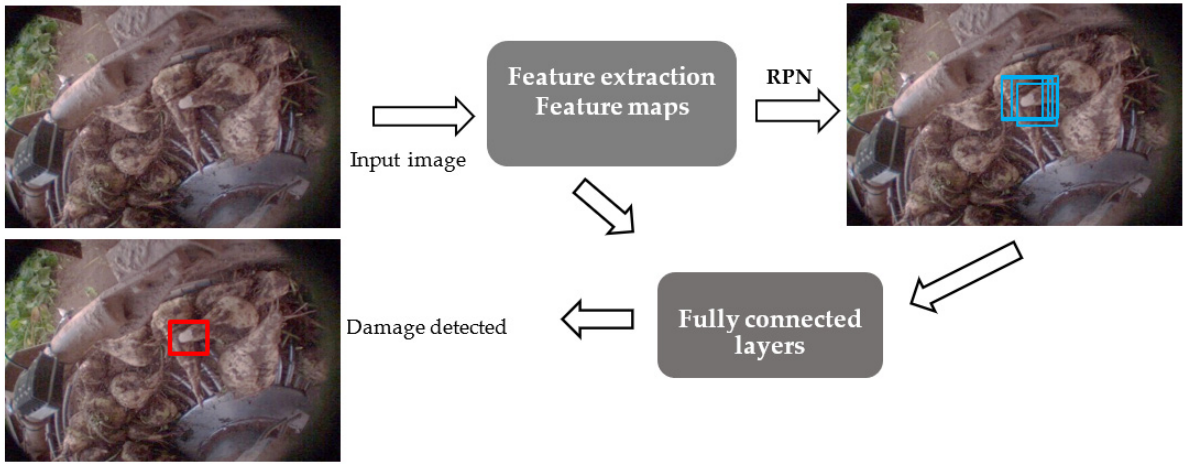
Figure 5. Schematic representation of Faster R-CNN for sugar beet damage